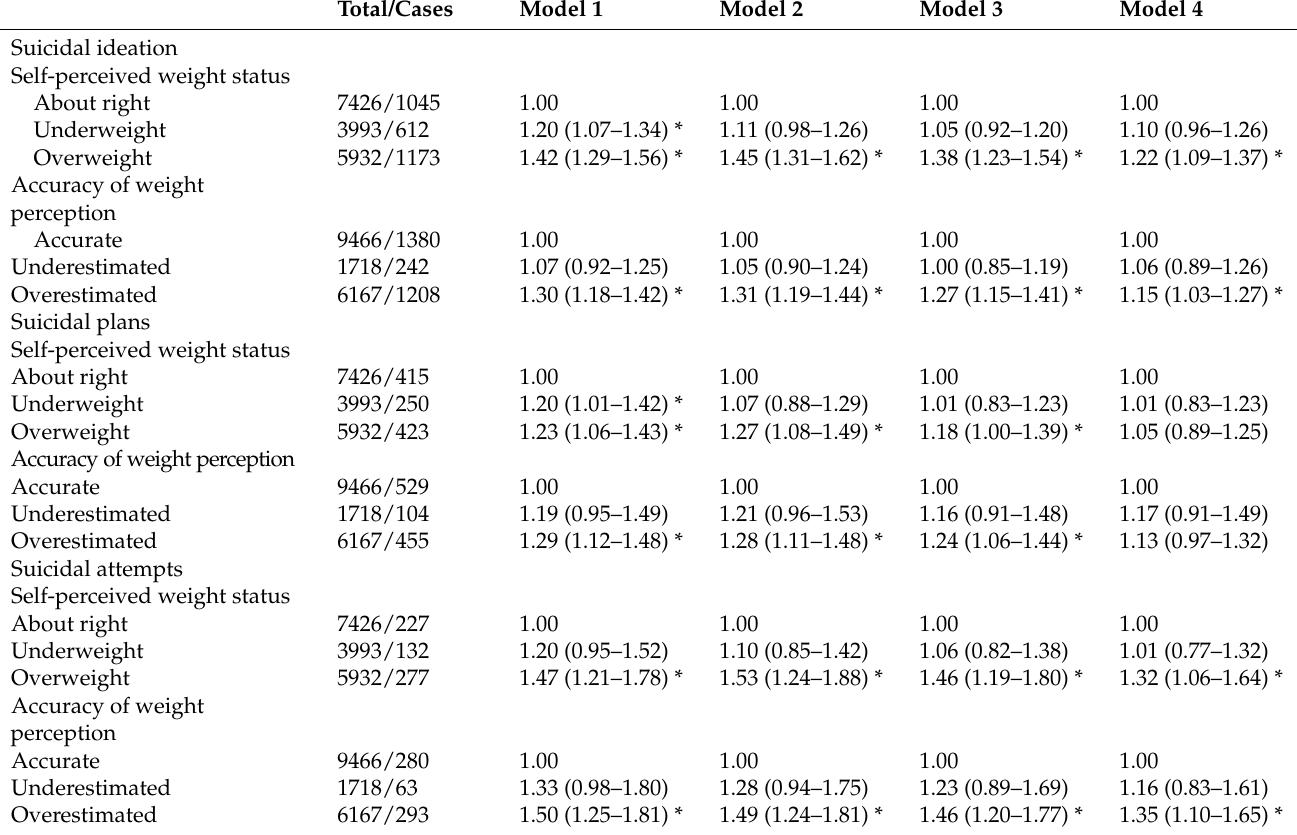
Table 2. Adjusted odds ratios (95% CIs) of suicidal ideation, plans and attempts by self-perceived weight status and the accuracy of weight